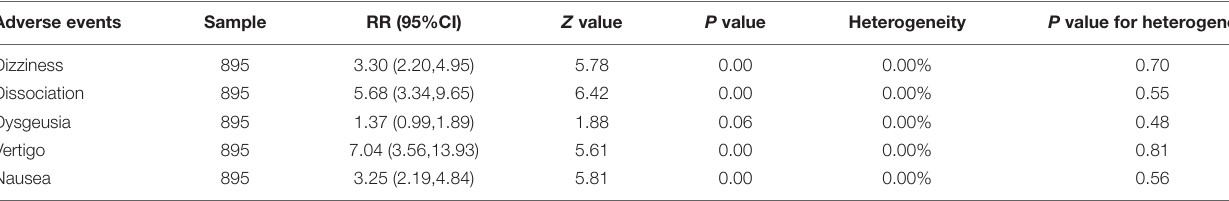
TABLE 3 | Forest plot results of commonly occurring adverse